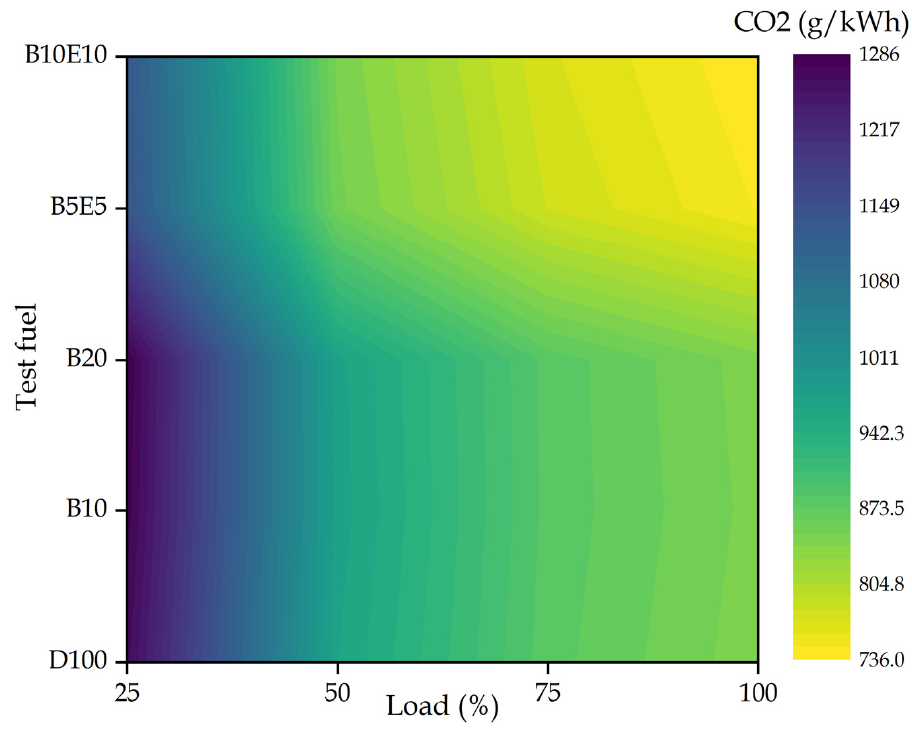
Figure 11. Variation in CO 2 emissions of tested fuel blends against engine loads.